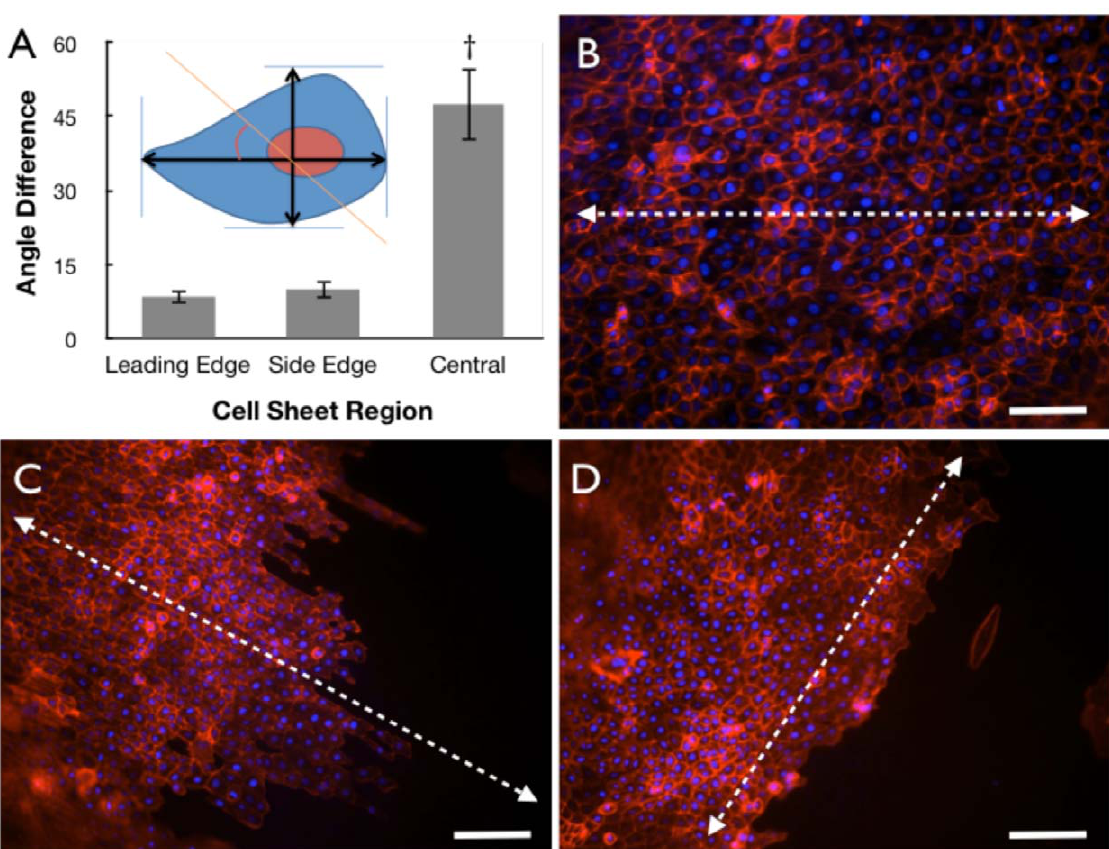
Figure 4. Border cells oriented by silk substrate topography. (A) Polarity of HCLE cells at the leading edge, side edge, and central regions of the cell sheet, with inset schematic illustrating measurement method (n=4, { indicates p , 0.05, error bars=standard deviations). (B–D) Actin (red) and nuclei (blue) staining of cells located within the (B) central region and (C–D) border regions of the migrating cell sheet with arrows indicating patterned feature edge axis (scale bar=100- m